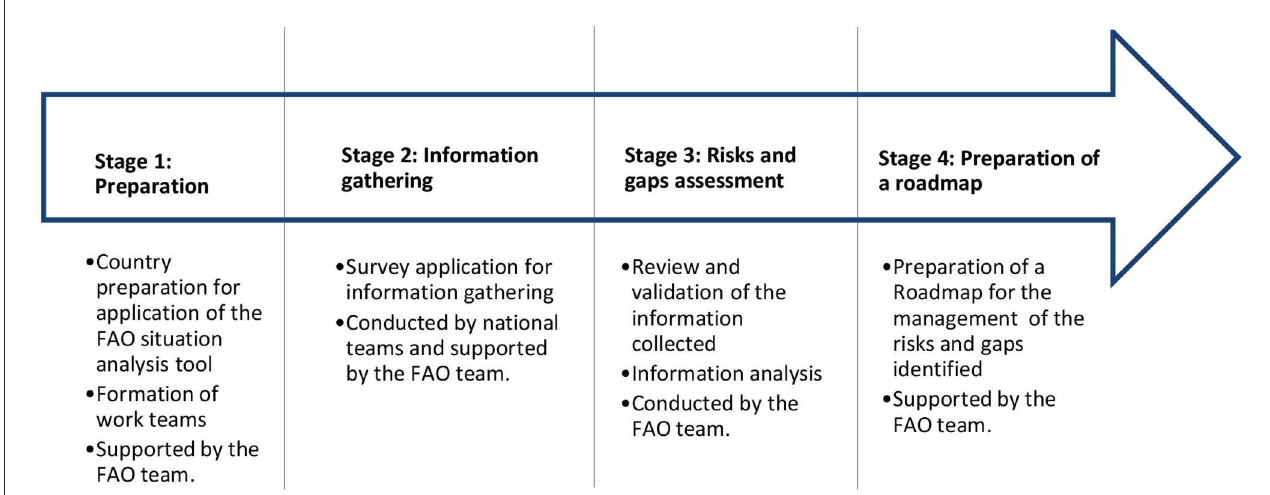
FIGURE2 Stages for the application of the FAO situation analysis